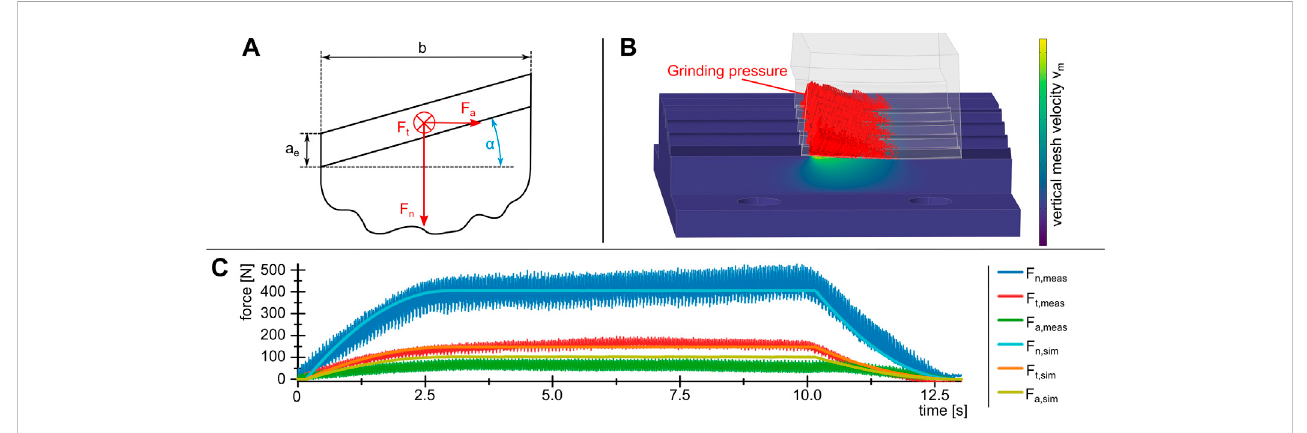
FIGURE 8 (A) Pro fi le angle α and the resulting axial force component F a . (B) FE model with the grinding pressure distribution in the grinding zone, and (C) the comparison of the transient measured and simulated force